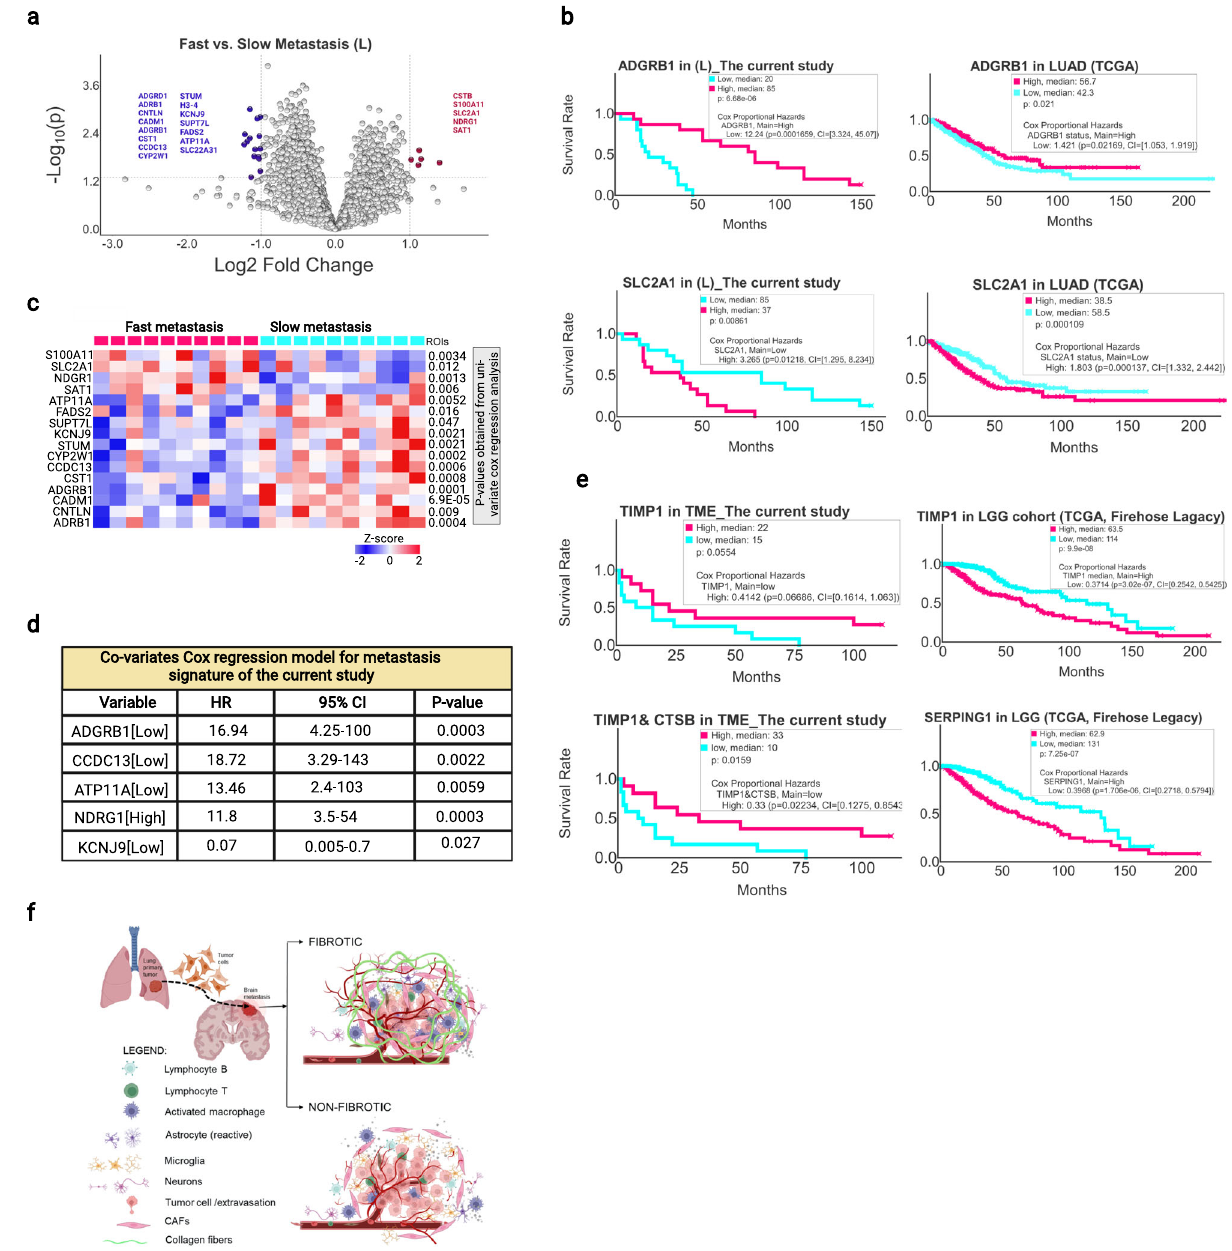
Fig. 8 | Signature genes of metastasis predict patient outcomes. a Volcano plot ofDEGsbetweentheLgroupswithfastandslowmetastasis. P valueswereobtained from the Student t test (two-sided). b Selective examples of Kaplan – Meier survival analysisand Coxproportionalhazardsofthecurrentcohort( n =30)and theTCGA LAUD cohort ( n =501) using individual metastasis signature genes. c Heatmap of signi fi cantly up- or downregulated genes in the fast vs. slow metastasis L ROI groups. P values were based on Student ’ s t test. d A set of genes within the metastasis gene signature identi fi ed by multivariate Cox regression analysis